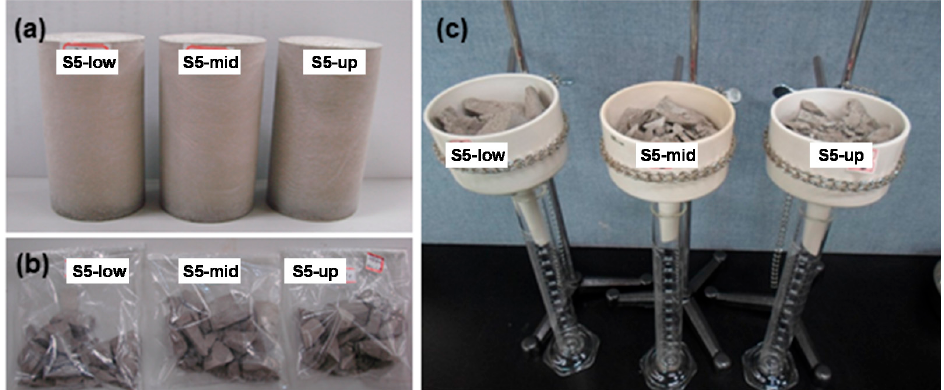
Figure 12. ( a ) Free-standing water test specimens, ( b ) Crushed specimens, and ( c ) Experimental settings for the test.